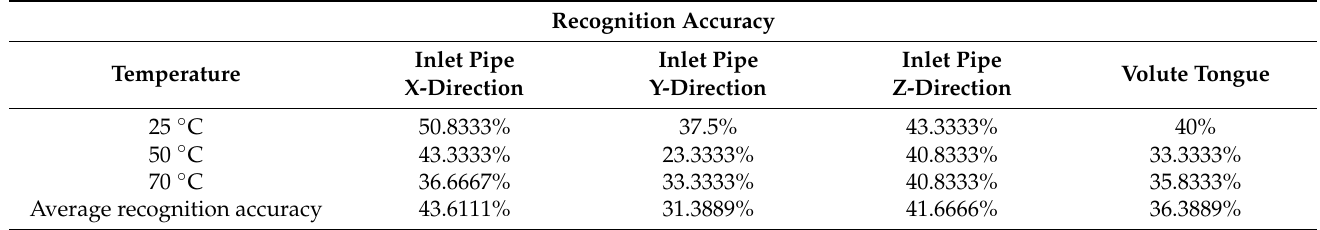
Table 5. Accuracy of multi-classification recognition of frequency domain combined eigenvalues.